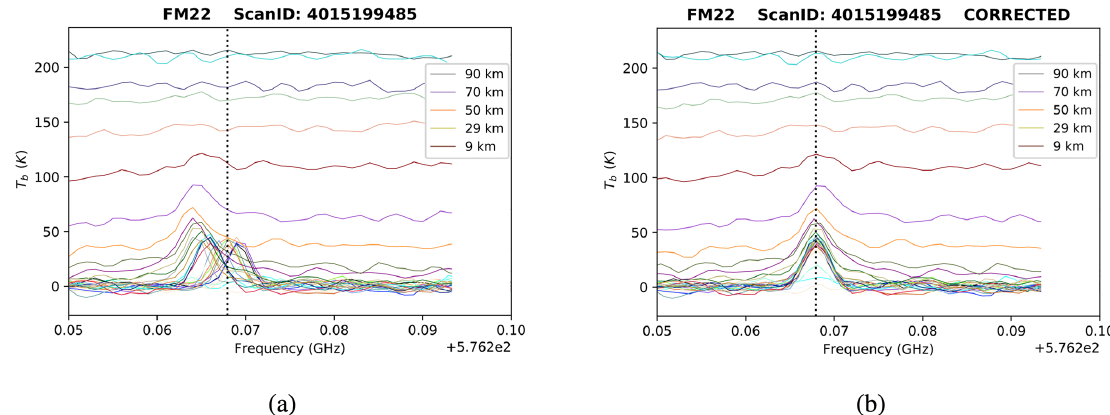
Figure 4. Spectra measured on 2 February 2009 presenting altitude-dependent frequency shifts before (a) and after (b) altitude-dependent correction. Colours corresponds to different tangent altitudes within the reported scan. Not all altitudes are indicated in the legend for the sake of